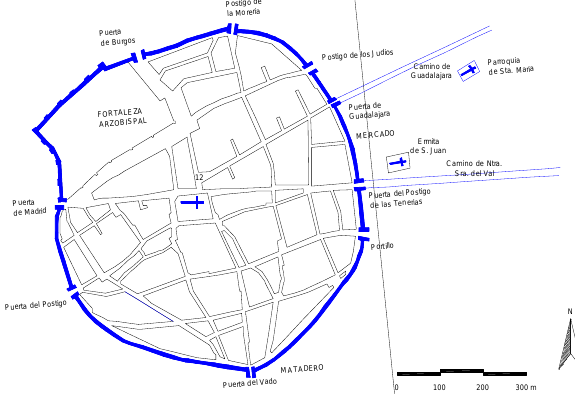
Figure 2. Hypothetical plant of Alcalá in XIV century.